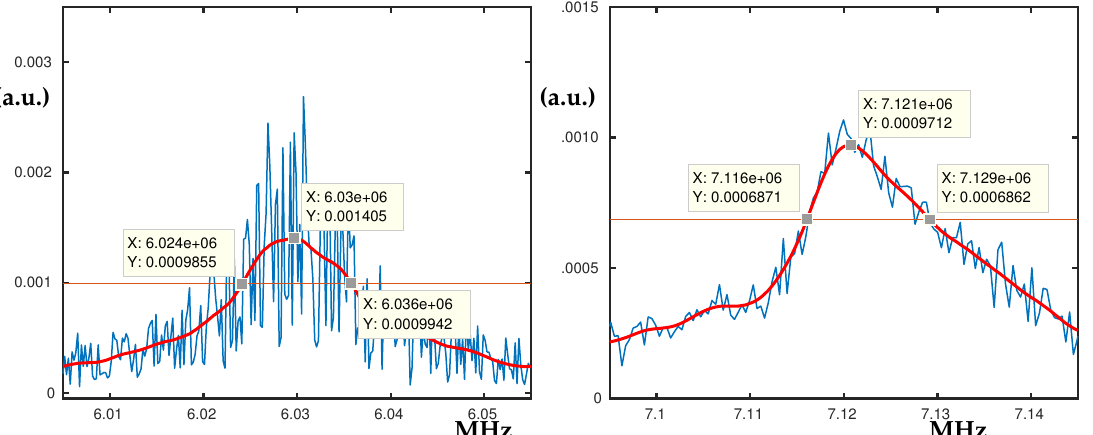
Figure A11. Matlab approximation by ’smoothdata’ function with Gaussian filter followed by Q-factor derivation that result in 518 and 544 for the 6.03 MHz and 7.121 MHz peaks